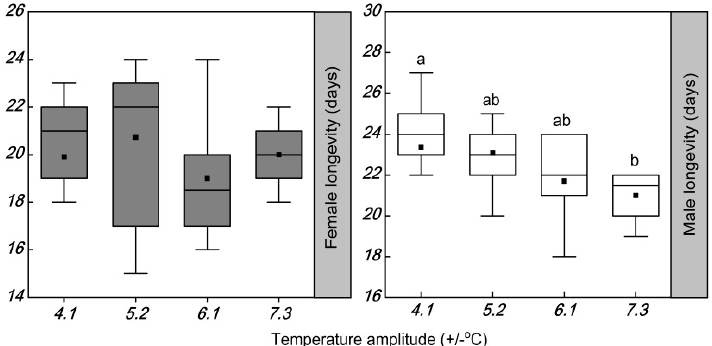
Figure 2. Box plot of the longevity of females and males of Plutella xylostella developed under four daily temperature amplitudes, with a similar mean temperature. The upper and lower boundaries of the box indicate the 75th percentile and 25th percentile of the data set. The black horizontal line and black square within the box represent the median and mean values, respectively. Error bars above and below the box indicate the minimum and maximum values, respectively. Different letters above each box indicate significant differences ( p < 0.05) among the